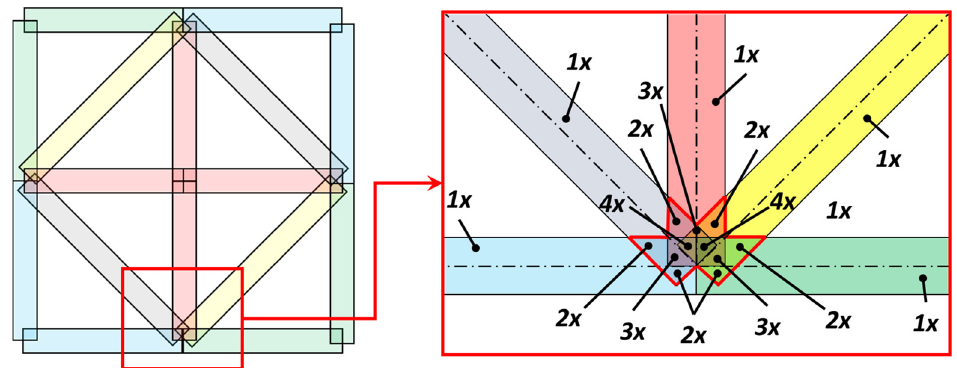
Figure 8. Schematization of overlapping regions.